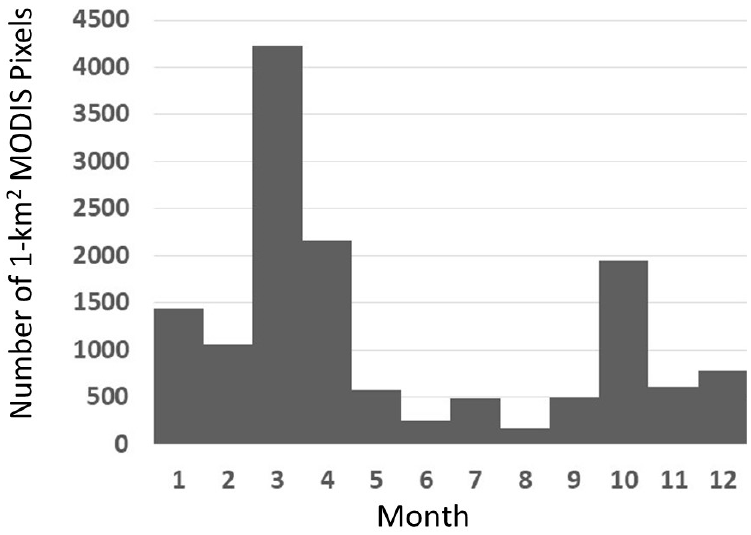
Figure 8. Monthly distribution of all breakpoints detected from structural change analysis of LST of the DRECP study area between 2000 and 2018 for the MODIS 1-km time series.